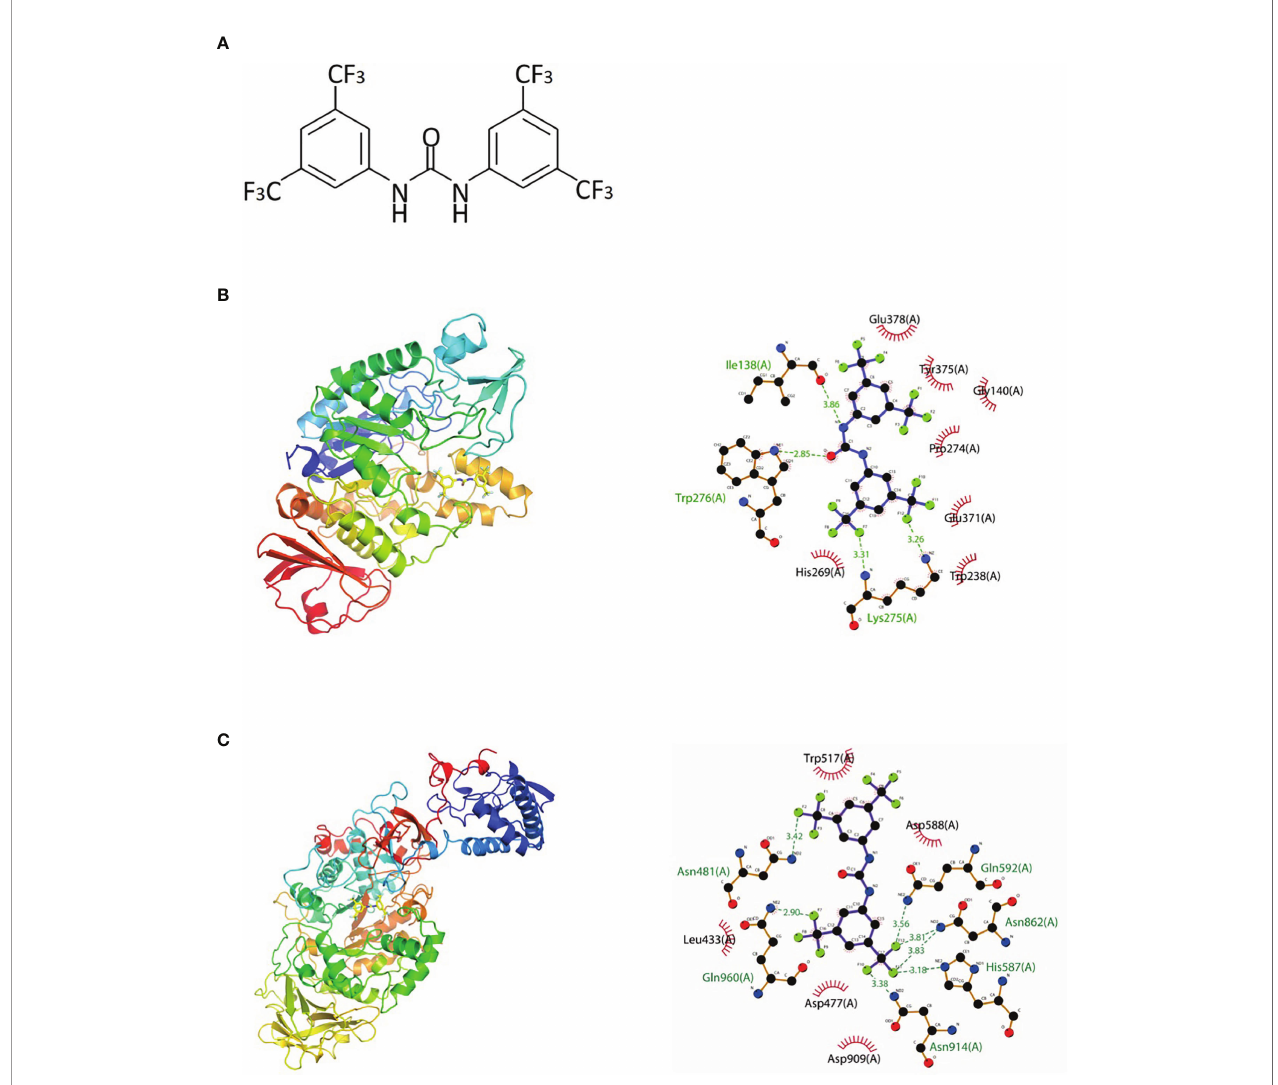
FIGURE 1 | Chemical structure and molecular docking analysis. (A) Chemical structure of 1,3-bis[3,5-bis(tri fl uoromethyl)phenyl]urea (BPU) molecule. (B, C) Predicted binding mode (left, 3D; right, 2D) of BPU molecule with 2ZID (B) and 3AIC (C) . Hydrogen bond is shown with green dashed lines (right). Hydrophobic interaction is shown with red “ eyelashes ”